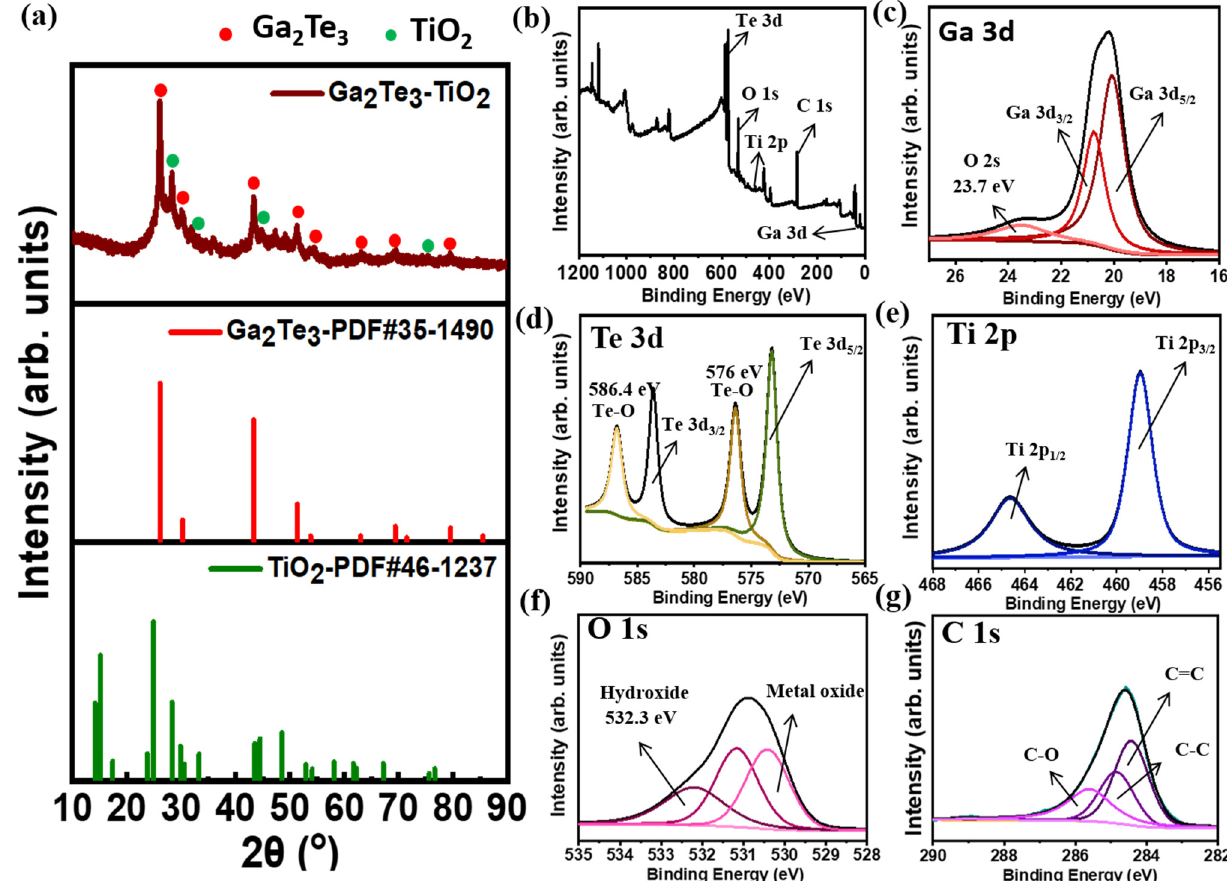
Figure 2. ( a ) XRD pattern of Ga 2 Te 3 -TiO 2 ; ( b ) XPS survey spectrum; ( c ) high-resolution XP spectra of Ga 3d; ( d ) Te 3d; ( e ) Ti 2p; ( f ) O 1 s and ( g ) C 1 s for Ga 2 Te 3 -TiO 2 -C (10%). Morphological and structural analyses of Ga 2 Te 3 -TiO 2 -C (10%) were investigated us- (10%), Ga 2 Te 3 -TiO 2 -C (20%), and Ga 2 Te 3 -TiO 2 -C (30%) are shown in Figure 4a and Figure